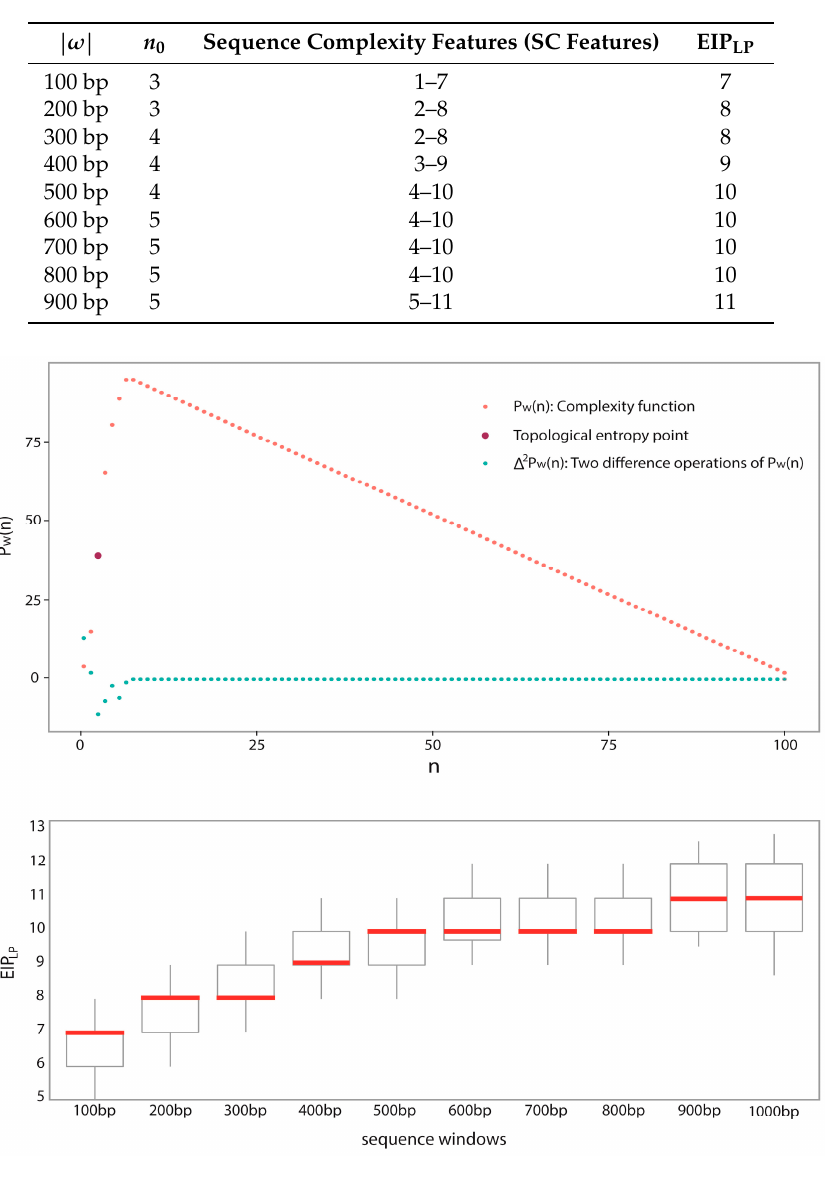
Figure 6. The determination approach of the exponentially increasing part of the complexity function graph: ( A ) The complexity function graph of 100-bp window DNA fragment with a methylated CpG site in the center. The red point represents the corresponding point of complexity function, the dark red point represents the point of the topological entropy point, and the blue point represents the corresponding point of two difference operations of complexity function; ( B ) The box plots of the distributions of EIP LP for different window sizes.